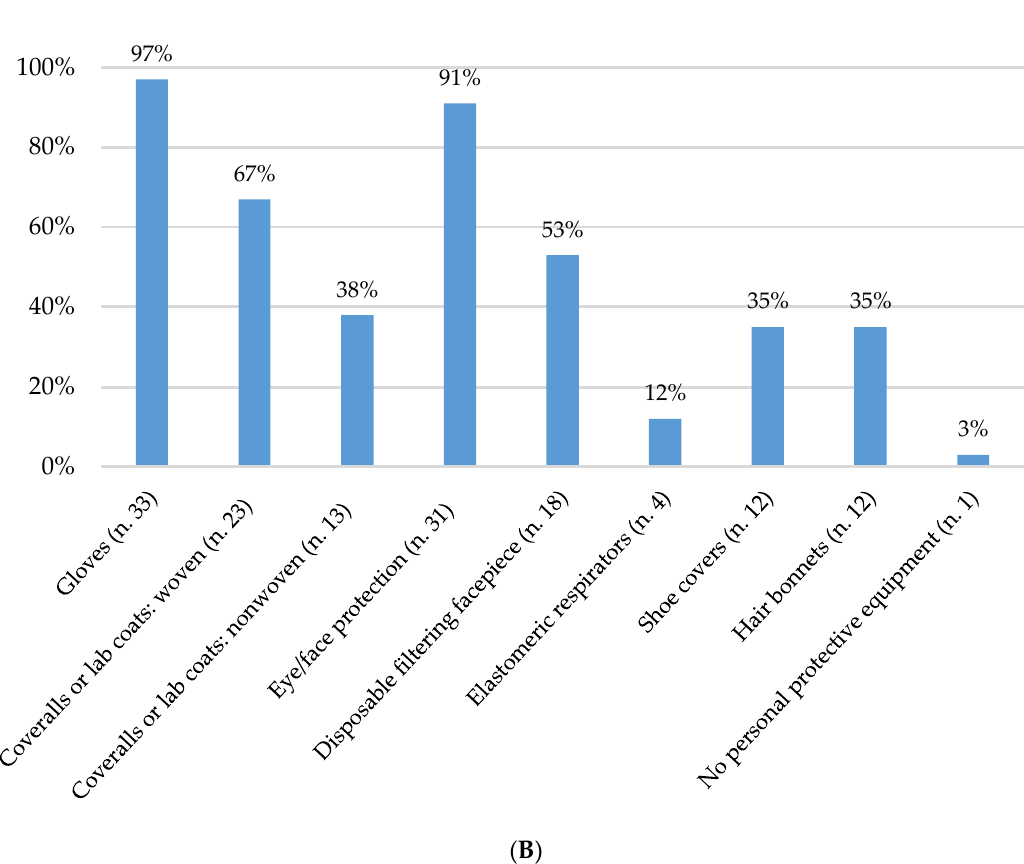
Figure 3. Engineering controls and personal protective equipment used for exposure control. ( A ) Collective protective devices ( n = number of respondent companies); percentages; ( B ) Personal protective equipment ( n = number of respondent companies); percentages.